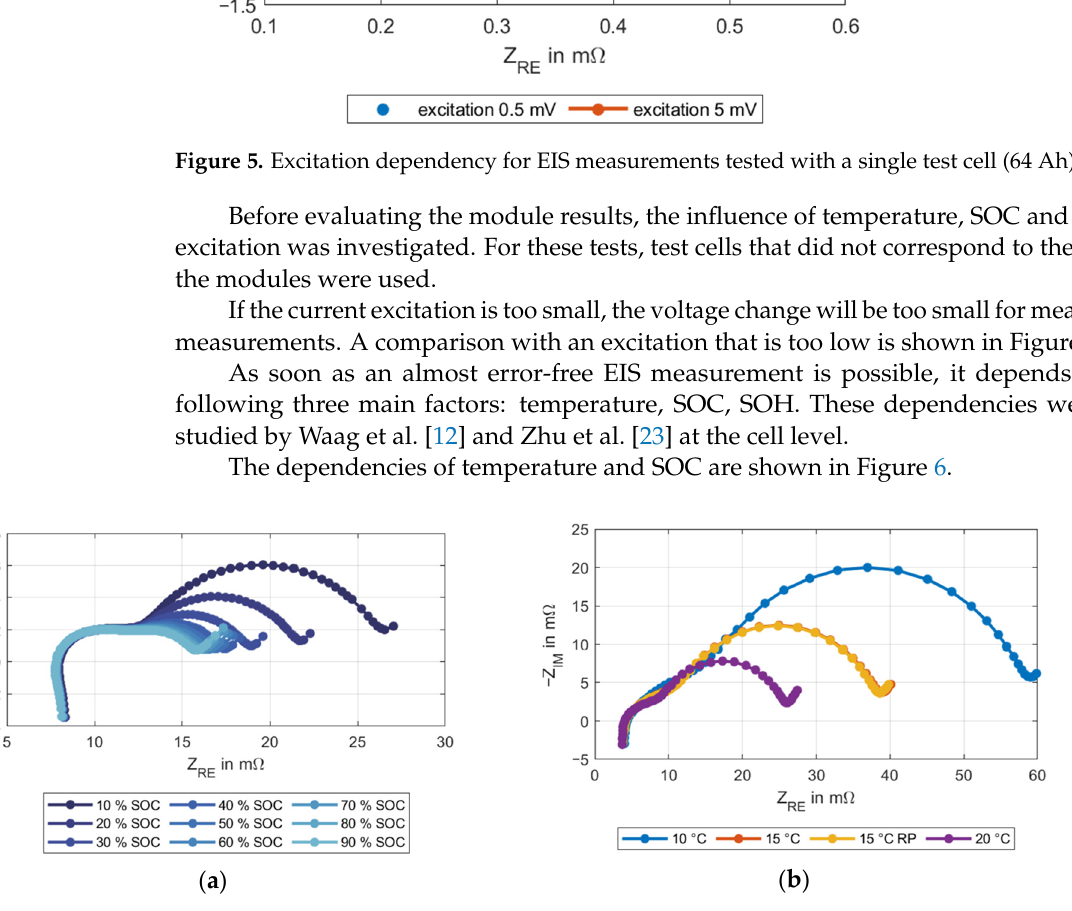
Figure 6. Schematic representation of spectra: ( a ) SOC dependence of the single test cell (5 Ah) measurement at 20 °C ( b ); temperature dependence of the single test cell (5 Ah) measurement at 20% SOC.